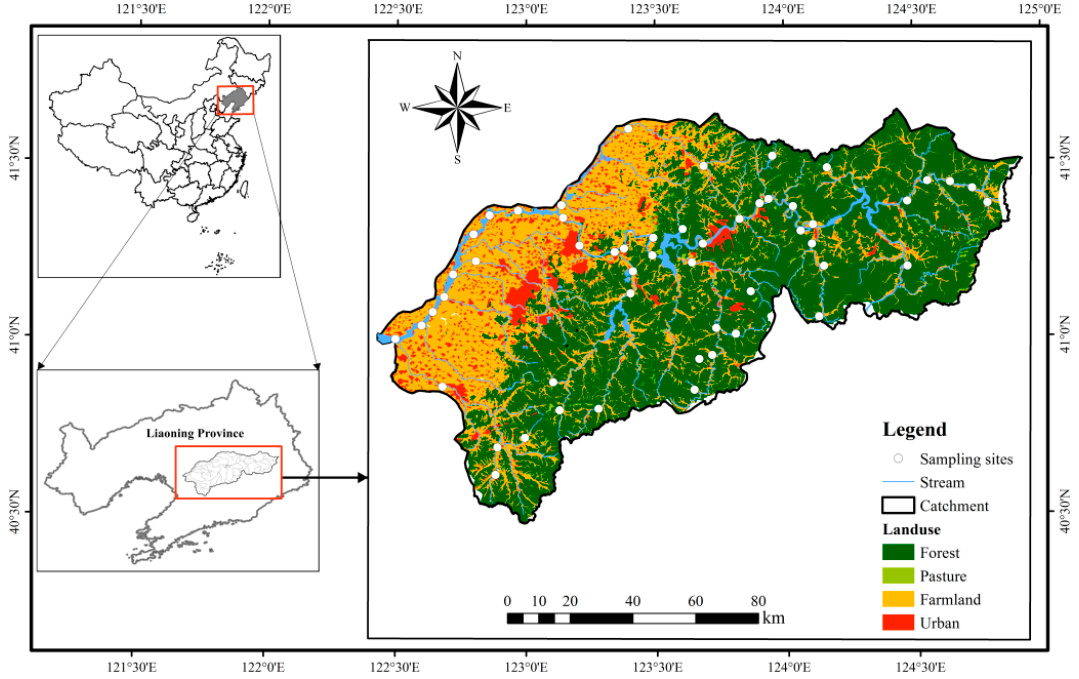
Figure 1. Study sites in the Taizi River catchment.